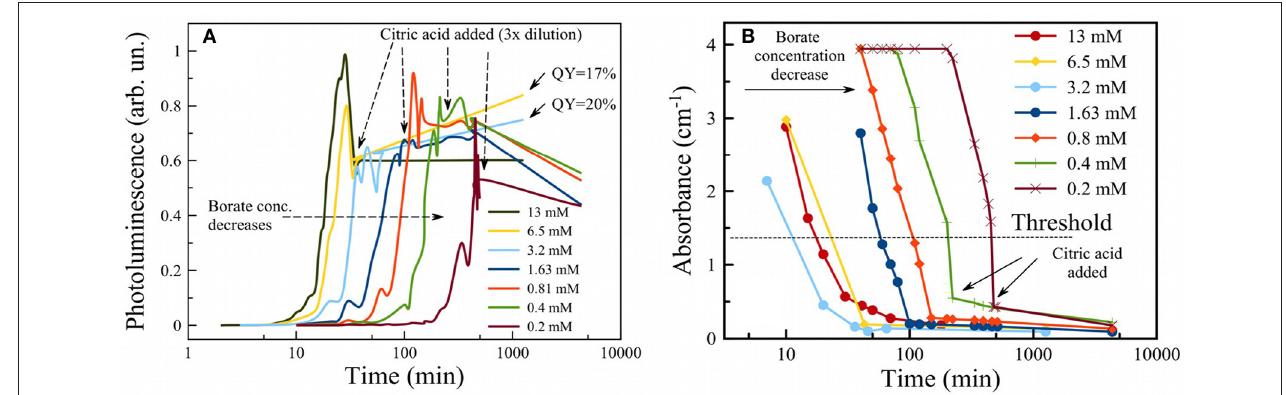
FIGURE 4 | Photoluminescence of PSiNPs during oxidation in aqueous borax with addition of citric acid to terminate the reaction (showed by vertical arrows) (A) . Initial borate concentrations for each trace are given in the legend. Absorbance of PSiNPs during the same process (B) .